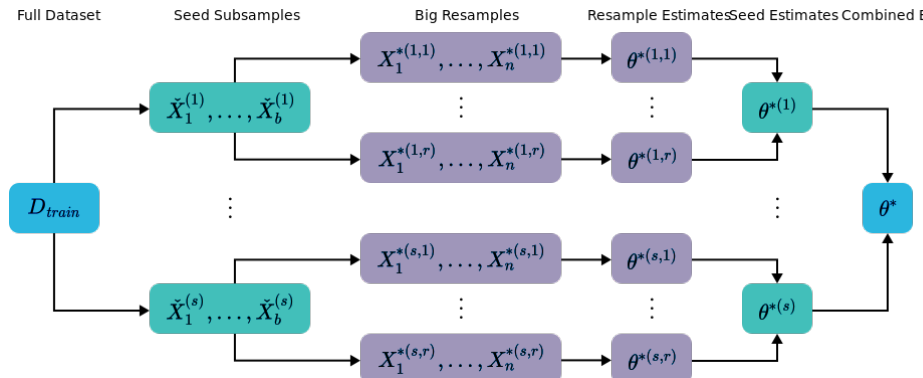
Figure 7. Overview of BOFN and BOOT steps of BLB.